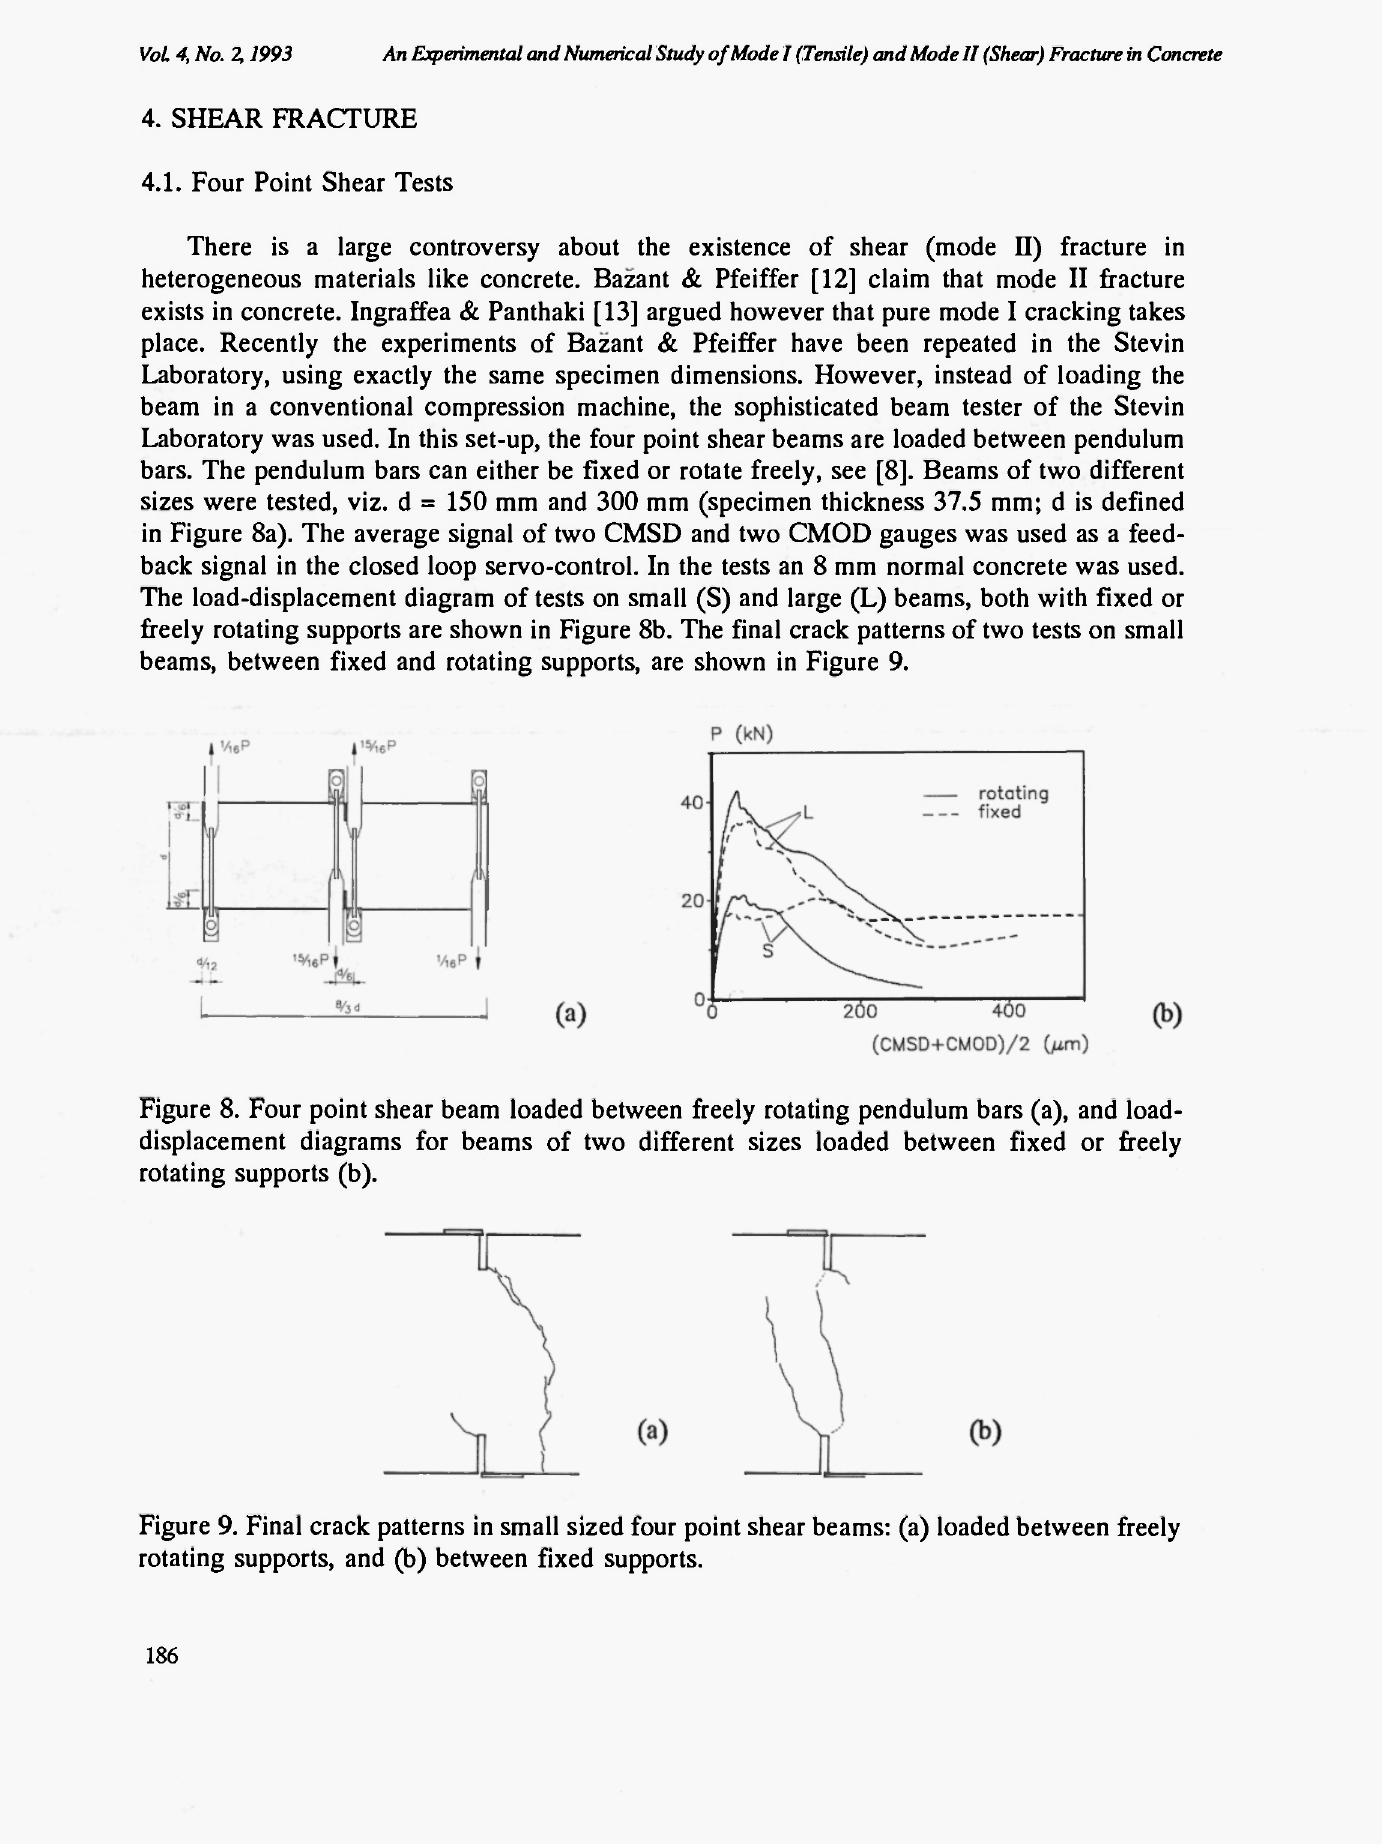
Figure 9. Final crack patterns in small sized four point shear beams: (a) loaded between freely rotating supports, and (b) between fixed